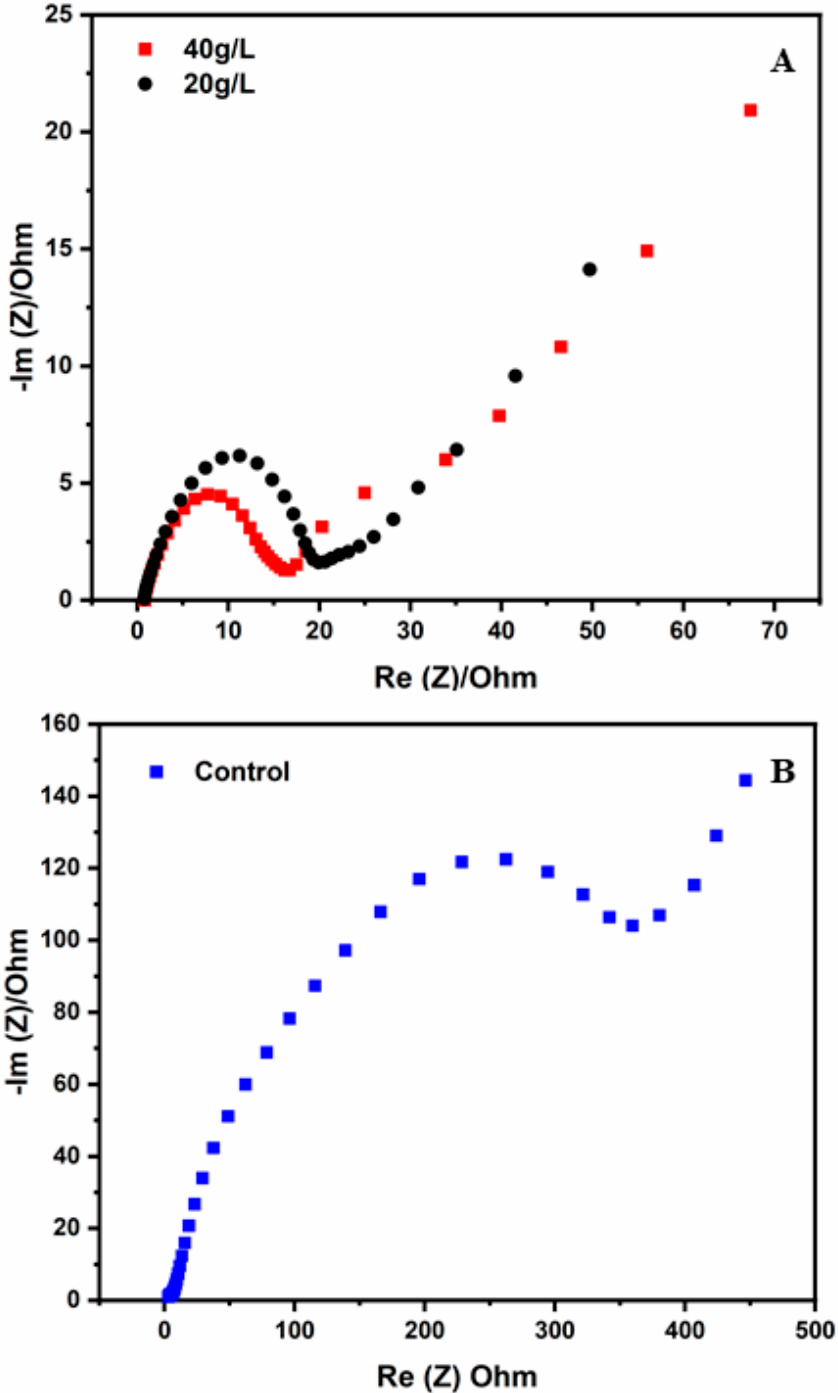
Figure 6. EIS profile while operating MFCs at ( A ) different salinities and ( B ) without microbes (con- trol